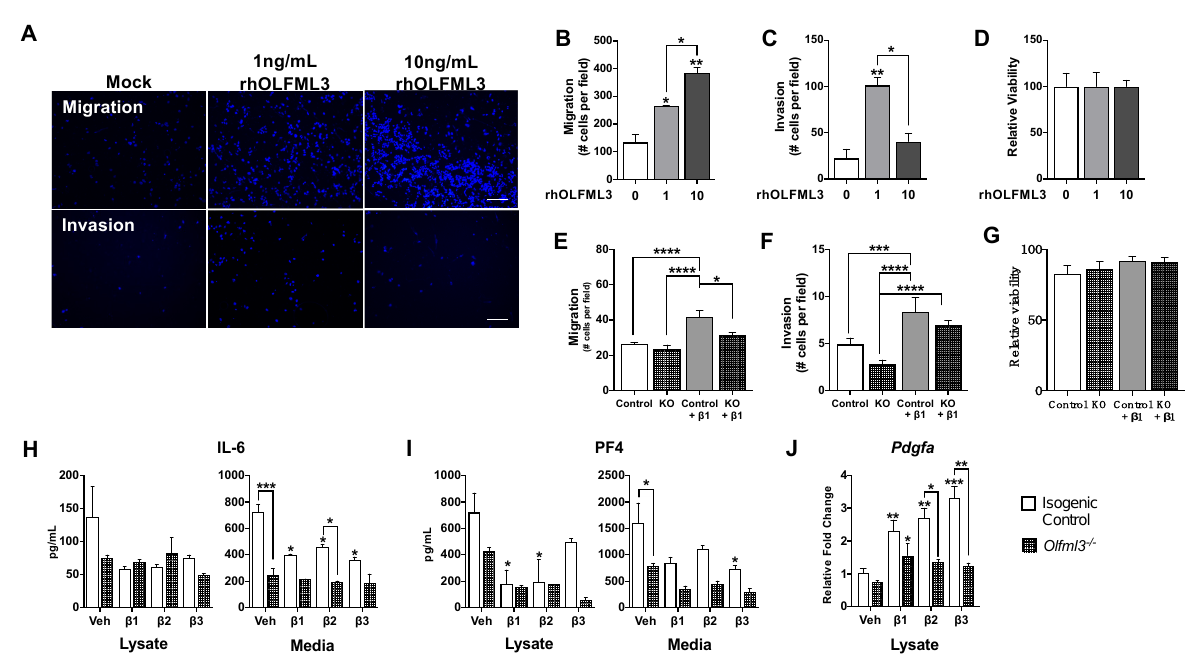
Toedebusch et. al. Figure 5, 2021 Figure 5. OLFML3 promotes glioma cell migration and invasion. ( A ) Representative images of glioma cell (GL261) migration and invasion following treatment with human recombinant OLFML3 (rhOLFML3; 1 ng/mL, 10 ng/mL); scale bar 20 µ